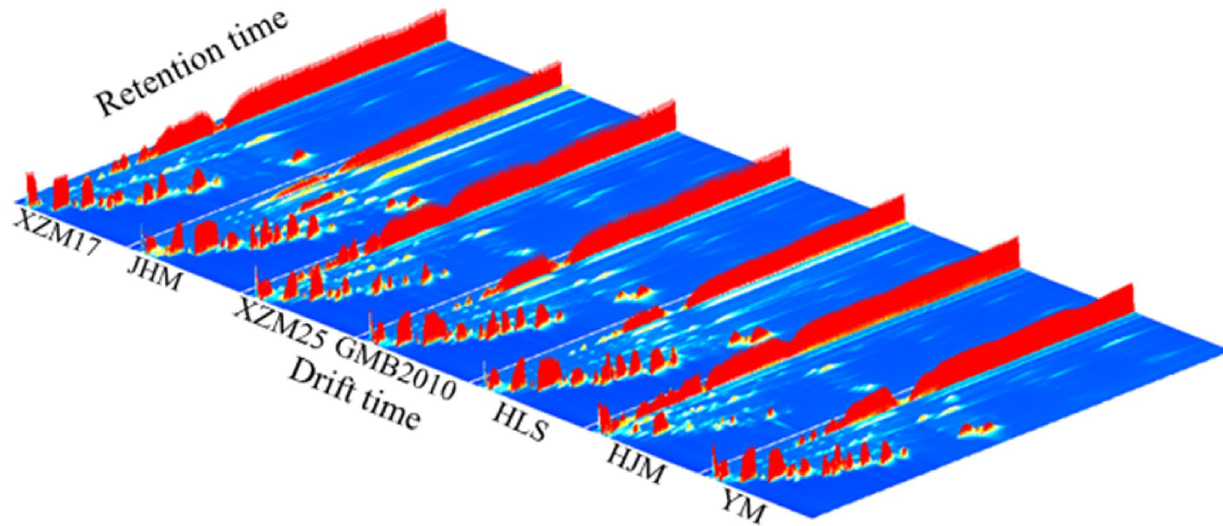
Fig. 5 Three-dimensional graph of VOCs in melon pulp